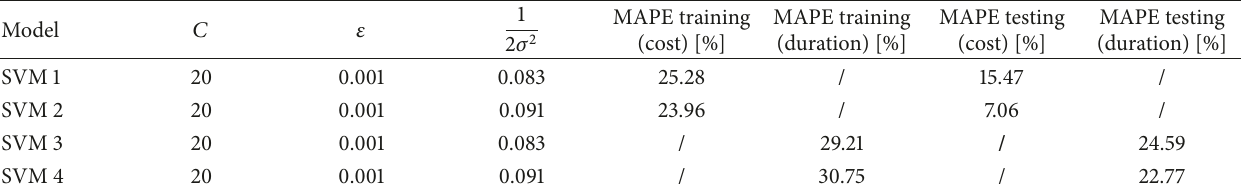
Table 10: SVM models